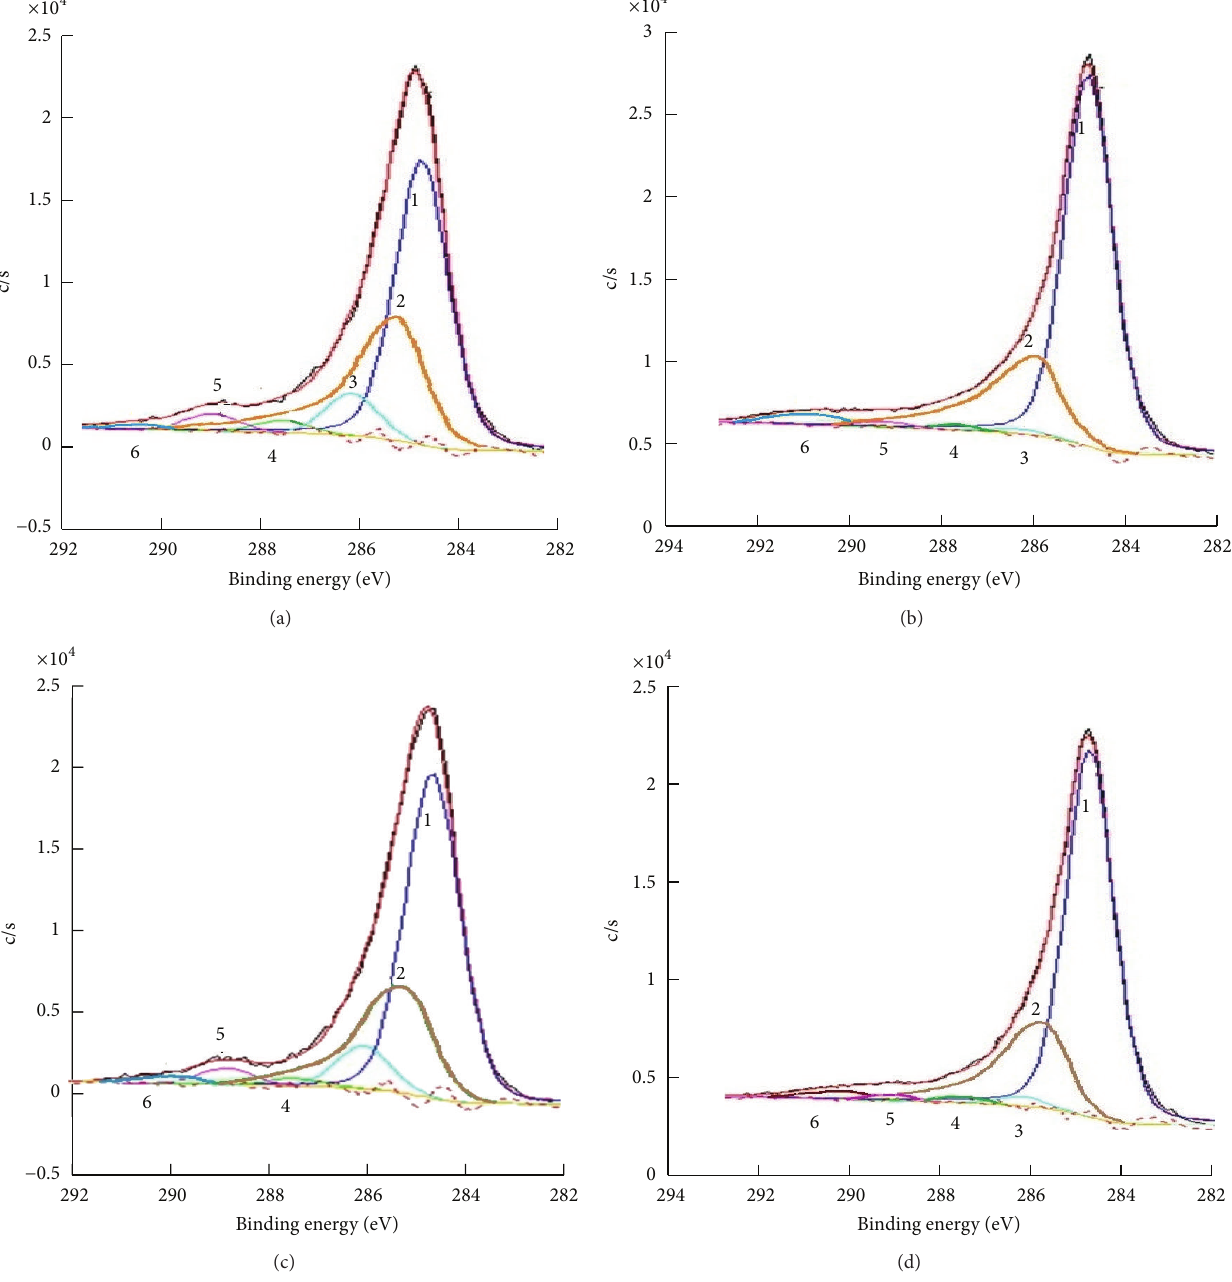
Figure 5: The C1s peaks in the XPS spectra of GNPs. (a) GNP; (b) GNP annealed without exposure to air; (c) GNP annealed then exposed to air; (d) GNP annealed then